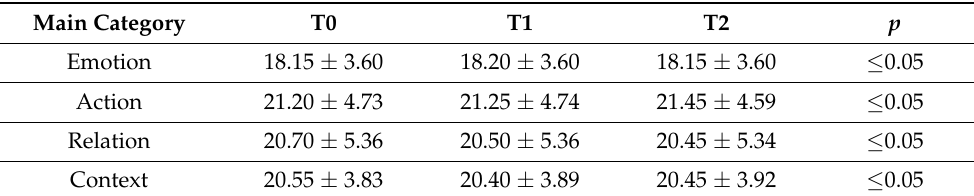
Table 2. Means and standard deviations of the Perceived Efficacy in Complex Situations Scale in different times of